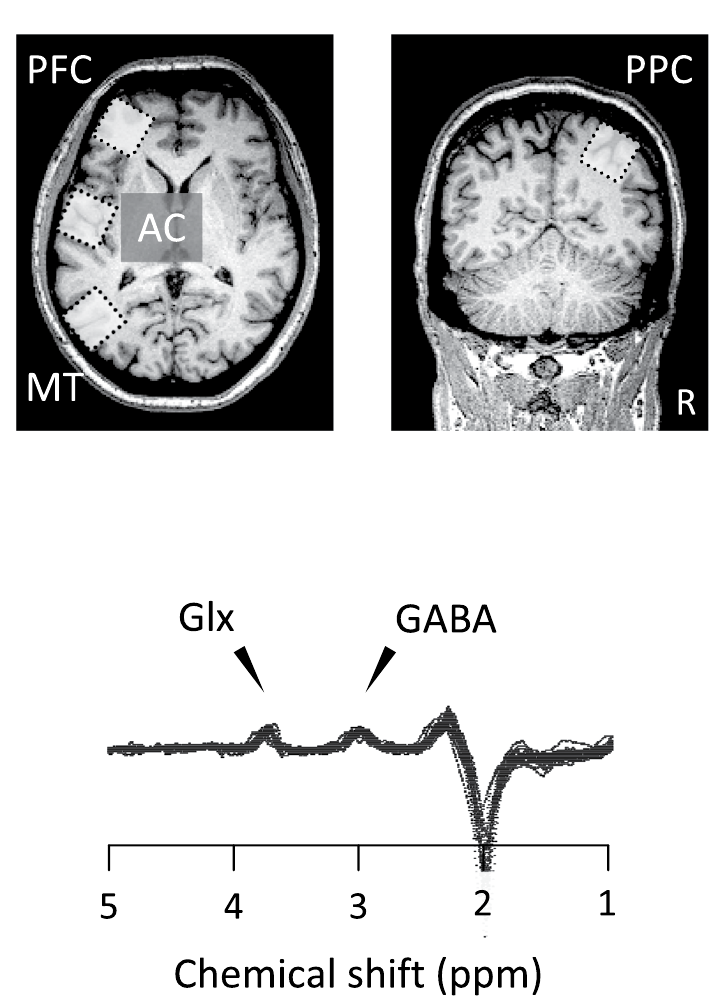
Figure 1. The size and location of voxels and the edited GABA spectra ( N = 36). ( A ) The voxel in the auditory cortex (AC) included the Heschl gyrus and the anterior part of the temporal plane. The voxel in the motion- sensitive area (MT) was placed at the ventrolateral occipital cortex. The voxel in the prefrontal cortex (PFC) was located at the anterior part of the middle frontal gyrus. The voxel in the posterior parietal cortex (PPC) was centred on the intraparietal sulcus. ( B ) The GABA and Glx peaks were calculated using the differences between AC spectra obtained by editing radio frequency on/off pulses. GABA, γ -aminobutyric acid; Glx, glutamate- glutamine; R,